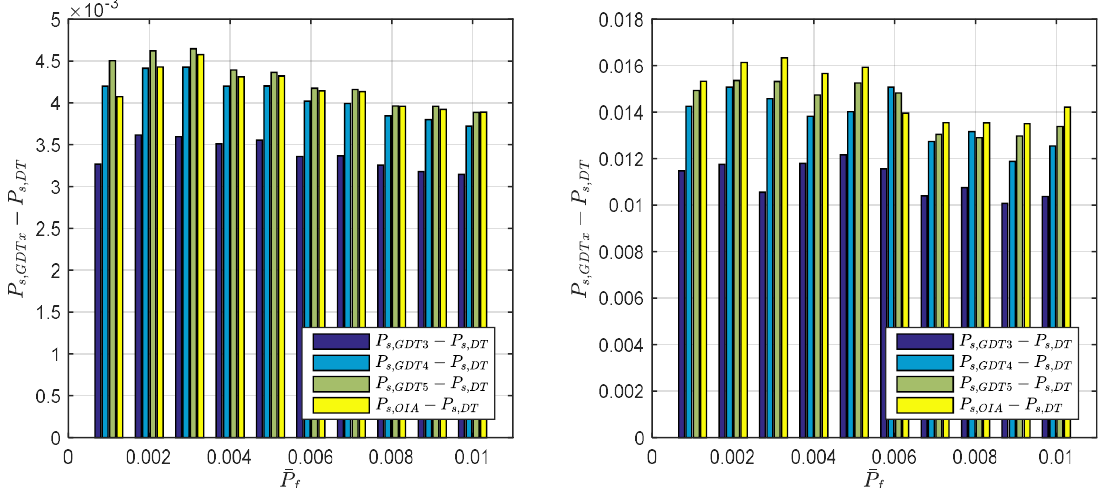
Figure 4. The impact of GDT term number on success rate subject to different failure rate tolerance: Mean value ( left ) and maximum value ( right ).